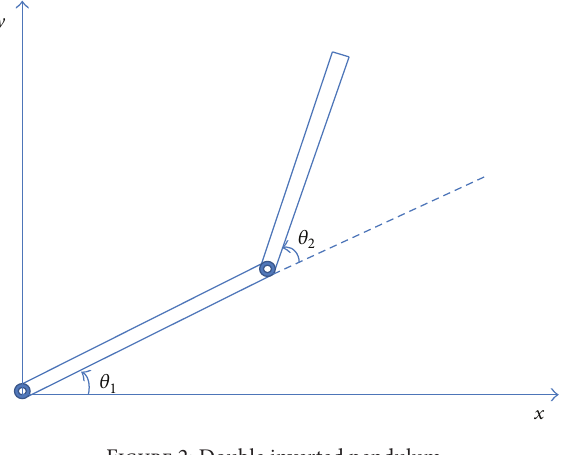
Figure 2: Double inverted pendulum.